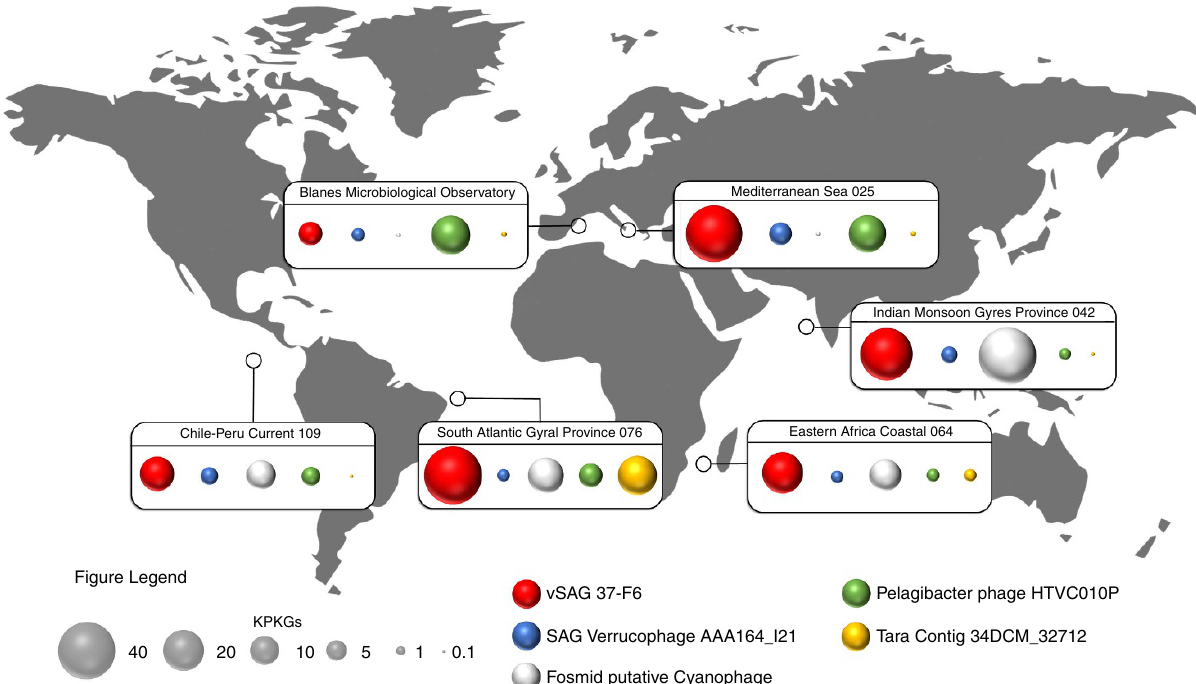
Figure 3 | Biogeography of most abundant marine viruses. The abundance of the most abundant surface dsDNA viruses for each virus genome data set according to the procedure for genome recovering (single-virus genomics (red), viruses from single bacterial cells 26 (blue), virus cloned in fosmids 10 (grey), virus isolates (green) and viromics from Tara Oceans data set (yellow) 2,3 . Fragment recruitment data were used to estimate the overall abundance for each region. Bubbles represent the fragment recruitment estimation expressed in KPKG (as in Fig.